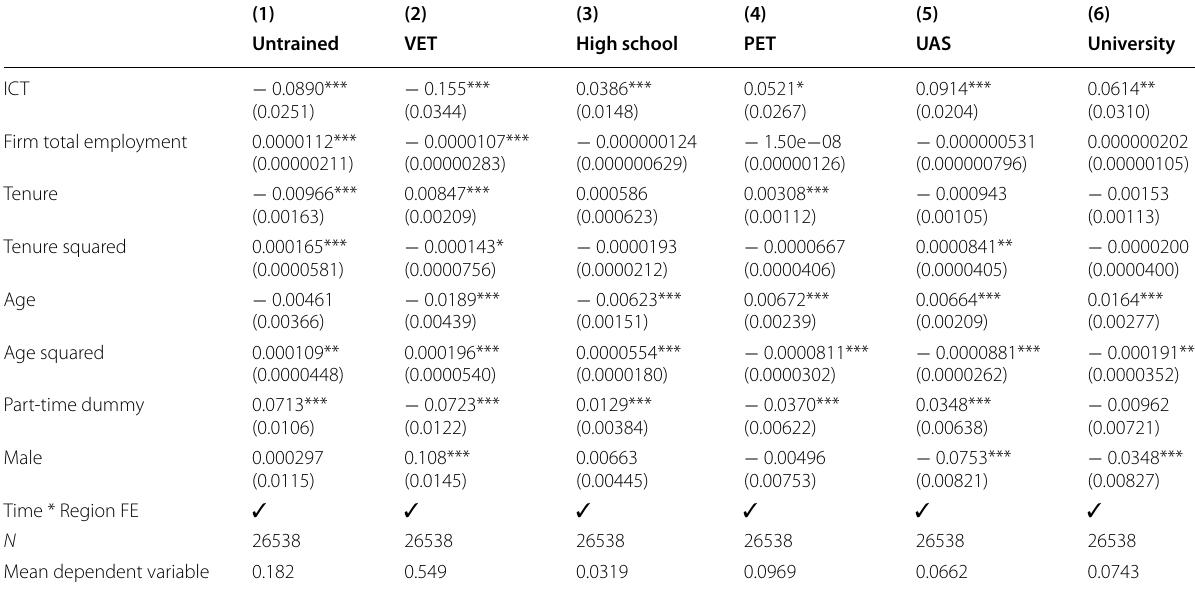
The table shows OLS coefficients of fixed effects estimates of a firm pseudo-panel with cells defined based on MS-region, industry, and firm size. Standard errors in parentheses are clustered at the cell level. N reports the number of pseudo-panel cells that contain at least one firm. The main explanatory variable measures the cell percentage of ICT workers according to ICT tasks (1996–2010) or ICT occupations (2012–2018). Estimates further control for time*MS-region fixed effects and cell averages of total employment, tenure, age, part-time status, and gender Each column shows the results for a different dependent variable measuring the